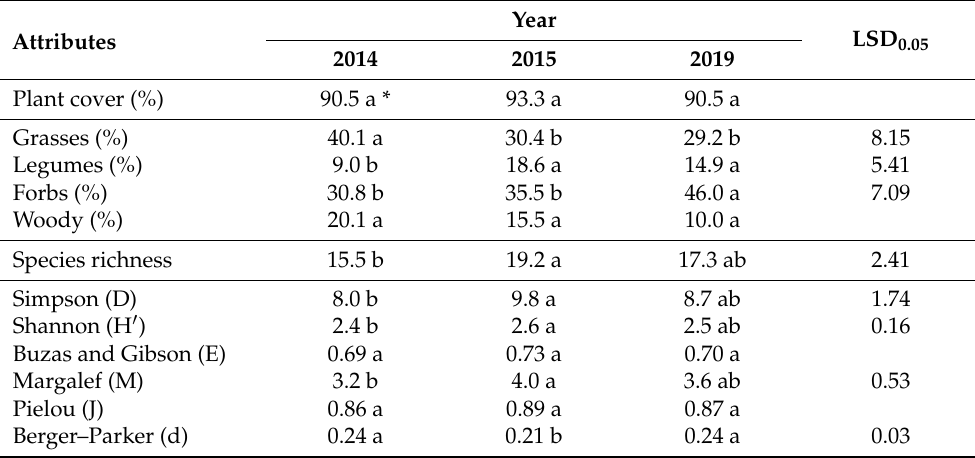
Table 4. Effects of years (across sites) on plant cover, functional group composition, and diversity indices.